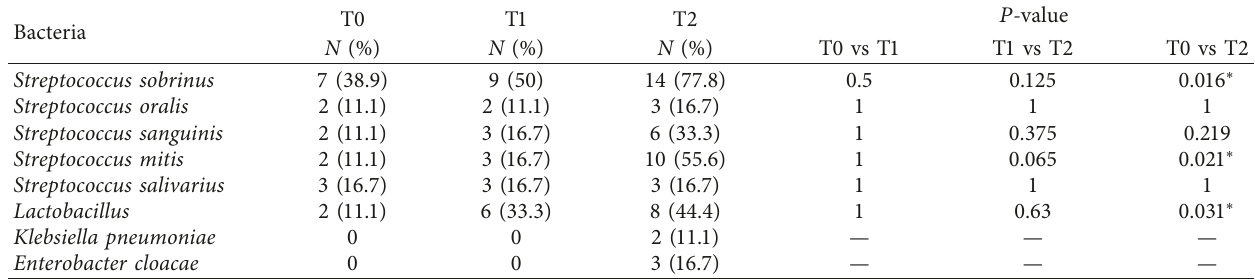
Table 1: Frequency of analyzed bacteria in dental plaque during three phases: before the placement of fixed appliances (T0), one month after the placement of fixed appliances (T1), and three months after the placement of fixed appliances (T2). T0 T1 Bacteria